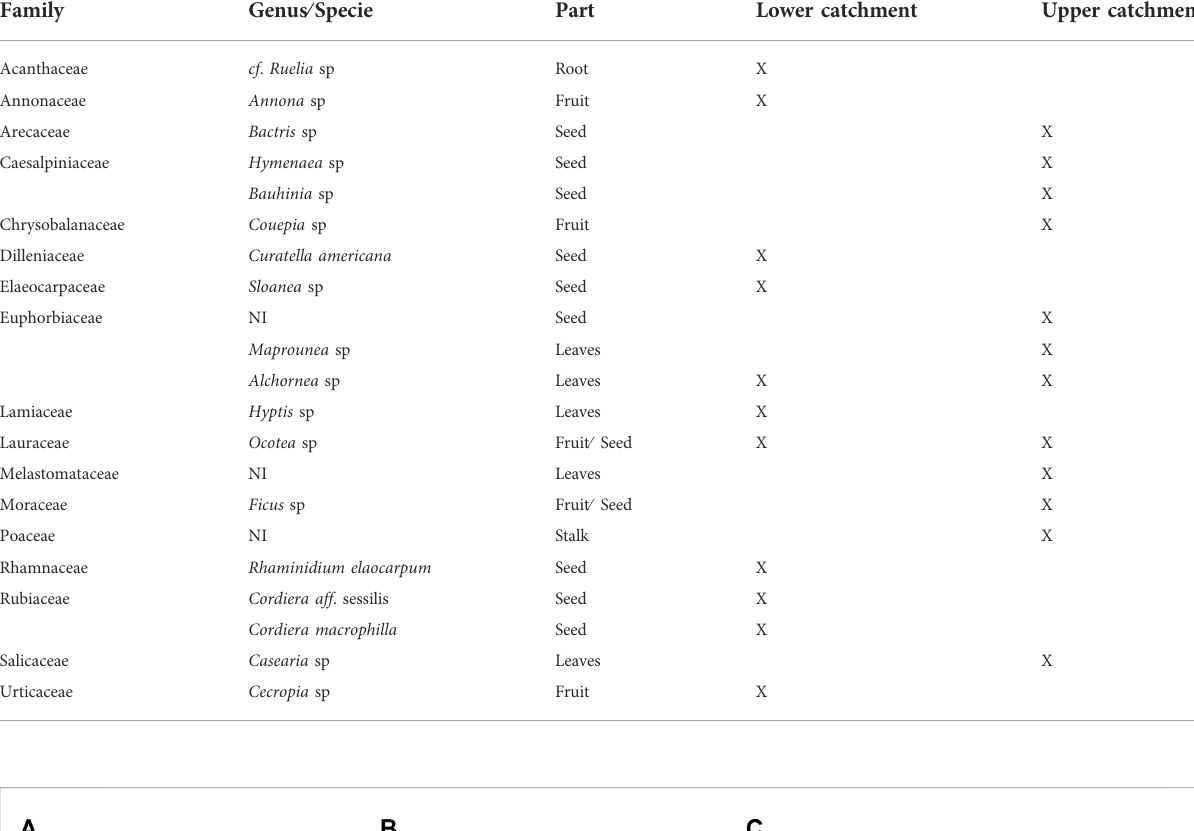
TABLE 1 Terrestrial plants identi fi ed in the stomach contents of Piaractus mesopotamicus at the sample sites. NI = not identi fi ed. Family